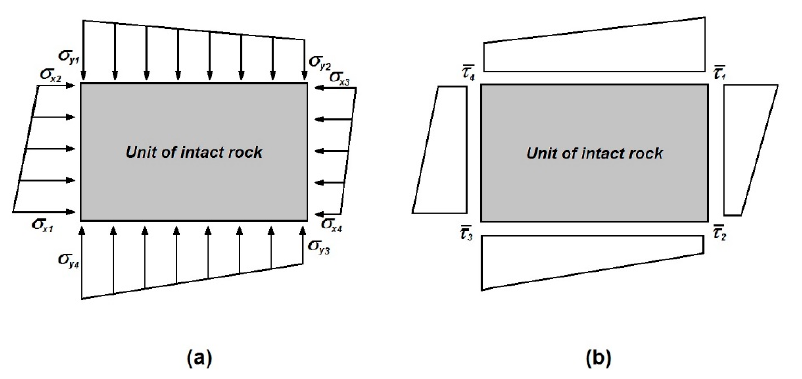
Figure 4. ( a ) Representation of normal stresses acting on the brick unit of rock, ( b ) distribution of shear stresses on the edges of the unit.